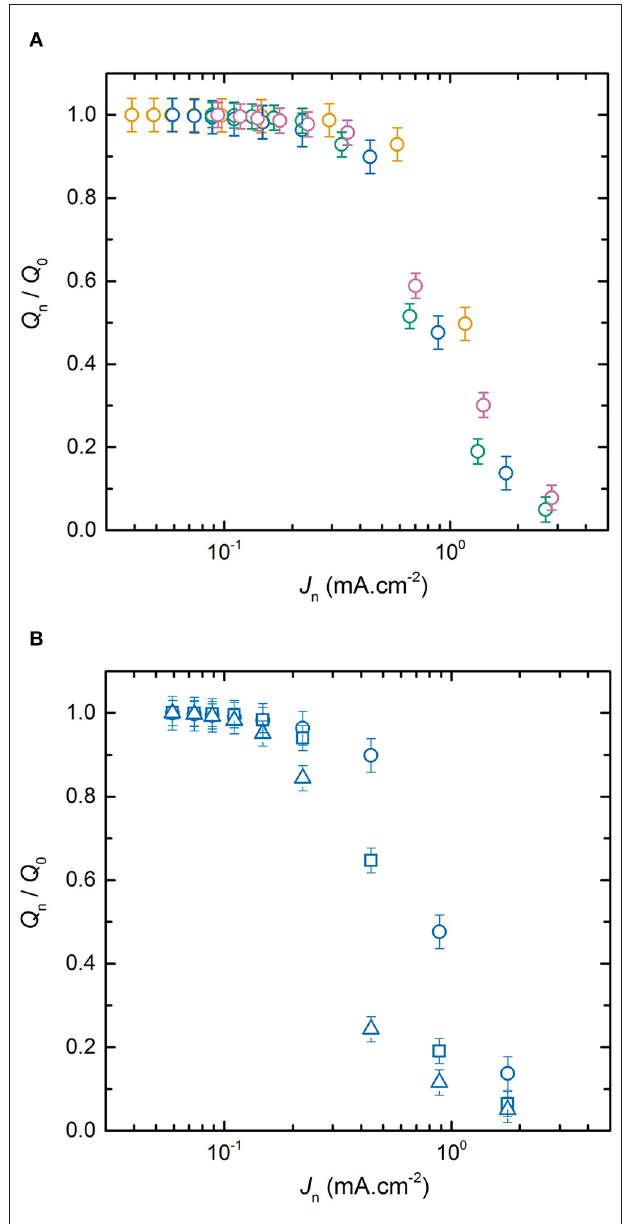
FIGURE 3 | Average normalized capacity, ratio Q n / Q 0 , as a function of the discharge current densities J n . (A) LMP( x -18) batteries with positive electrode thickness x of (orange) 20, (blue) 33, (green) 48, and (pink) 60 µ m; and (B) LMP(33- y ) batteries with SPE thickness y of ( (cid:13) ) 18, ( 2 ) 36, and ( △ ) 54 µ